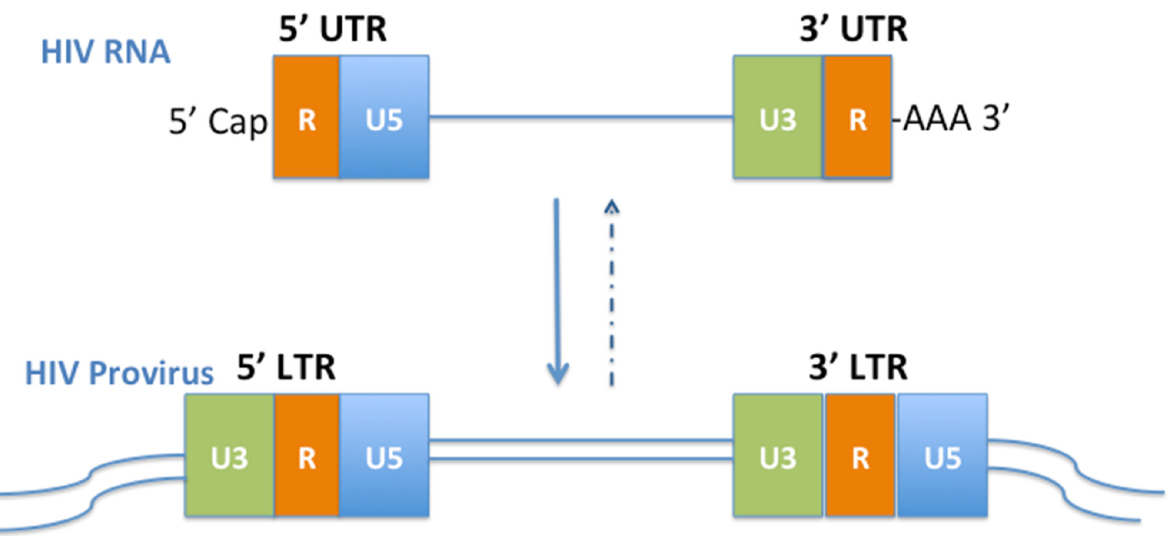
Figure 1. HIV UTR and LTR. U: unique element. R: repeat element. Provirus is a metastable stage in the retroviral lifecycle. A breach of the metastable equilibrium depends on the host cell signals not the virus. Based on the knowledge of X-chromosome inactivation and the stem cell features of CD4 T-cells, the host epigenetic silencing and cART can force the provirus into a stable state—a permanent silencing, similar to the ancient human endogenous retroviruses (HERVs) resided in our DNA.